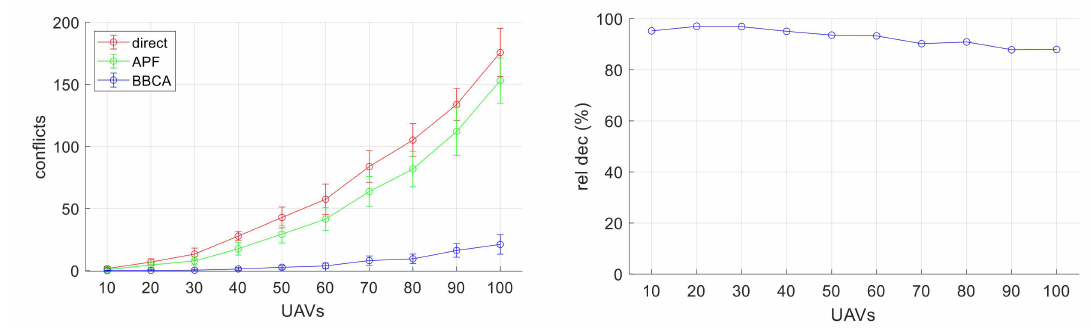
Figure 15. Multi-UAV study: conflicts produced; average and standard deviation values (left), and relative decrement of BBCA related to “direct” (right).